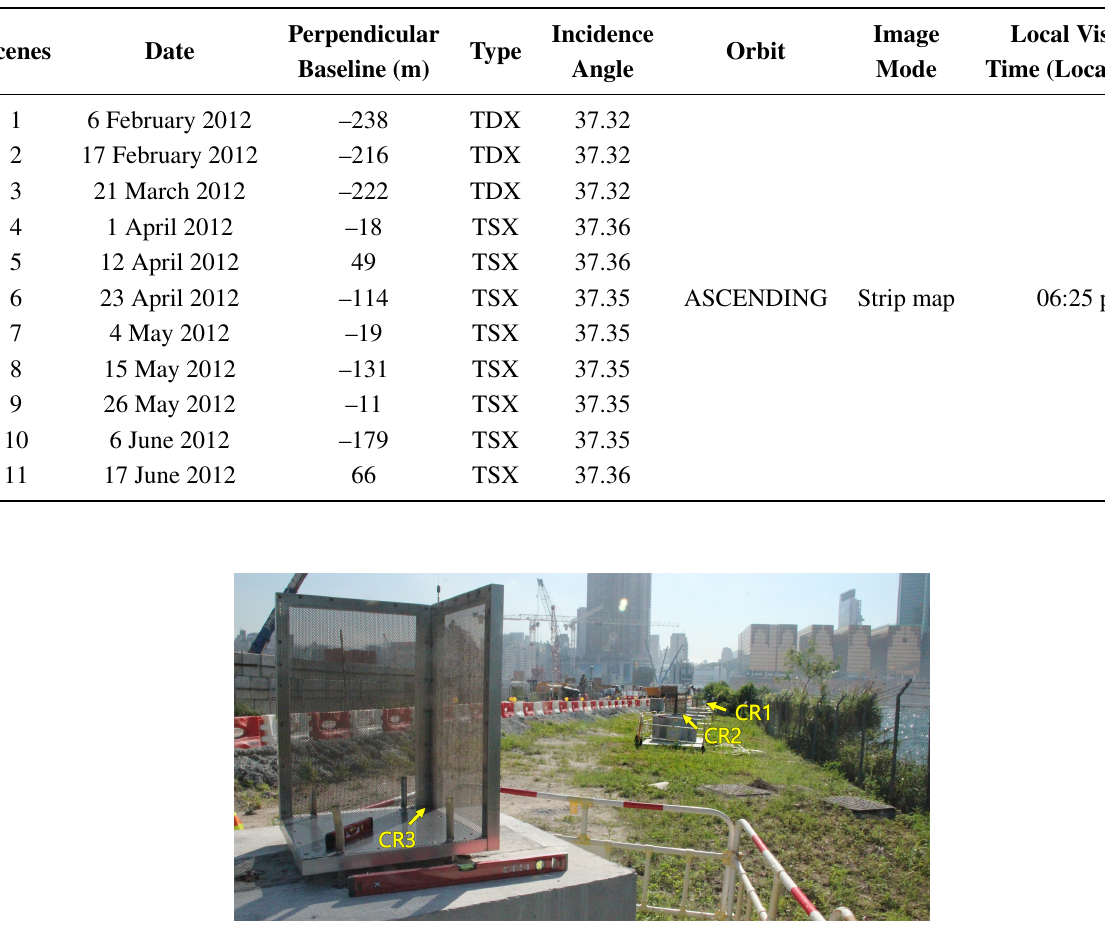
Table 1. List of TSX and TDX images used for the CR validation test.